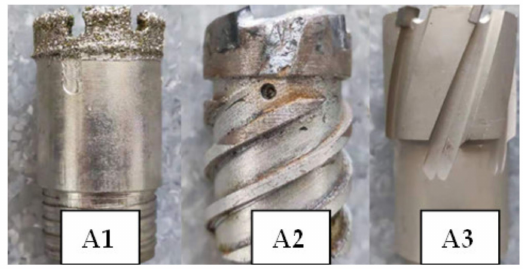
Figure 9. Drill bits used on the test bedrock samples.